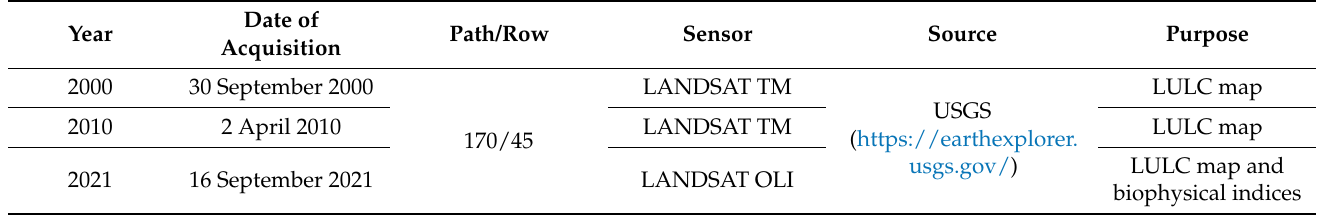
Table 1. Details of the data sources used in this study.